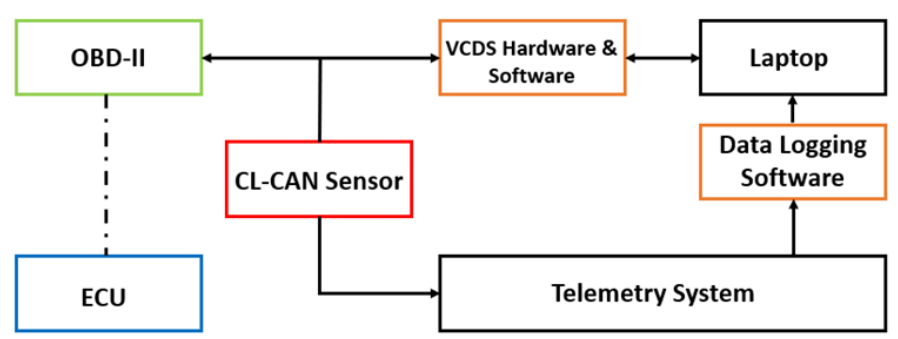
Figure 2. Data query schematic.